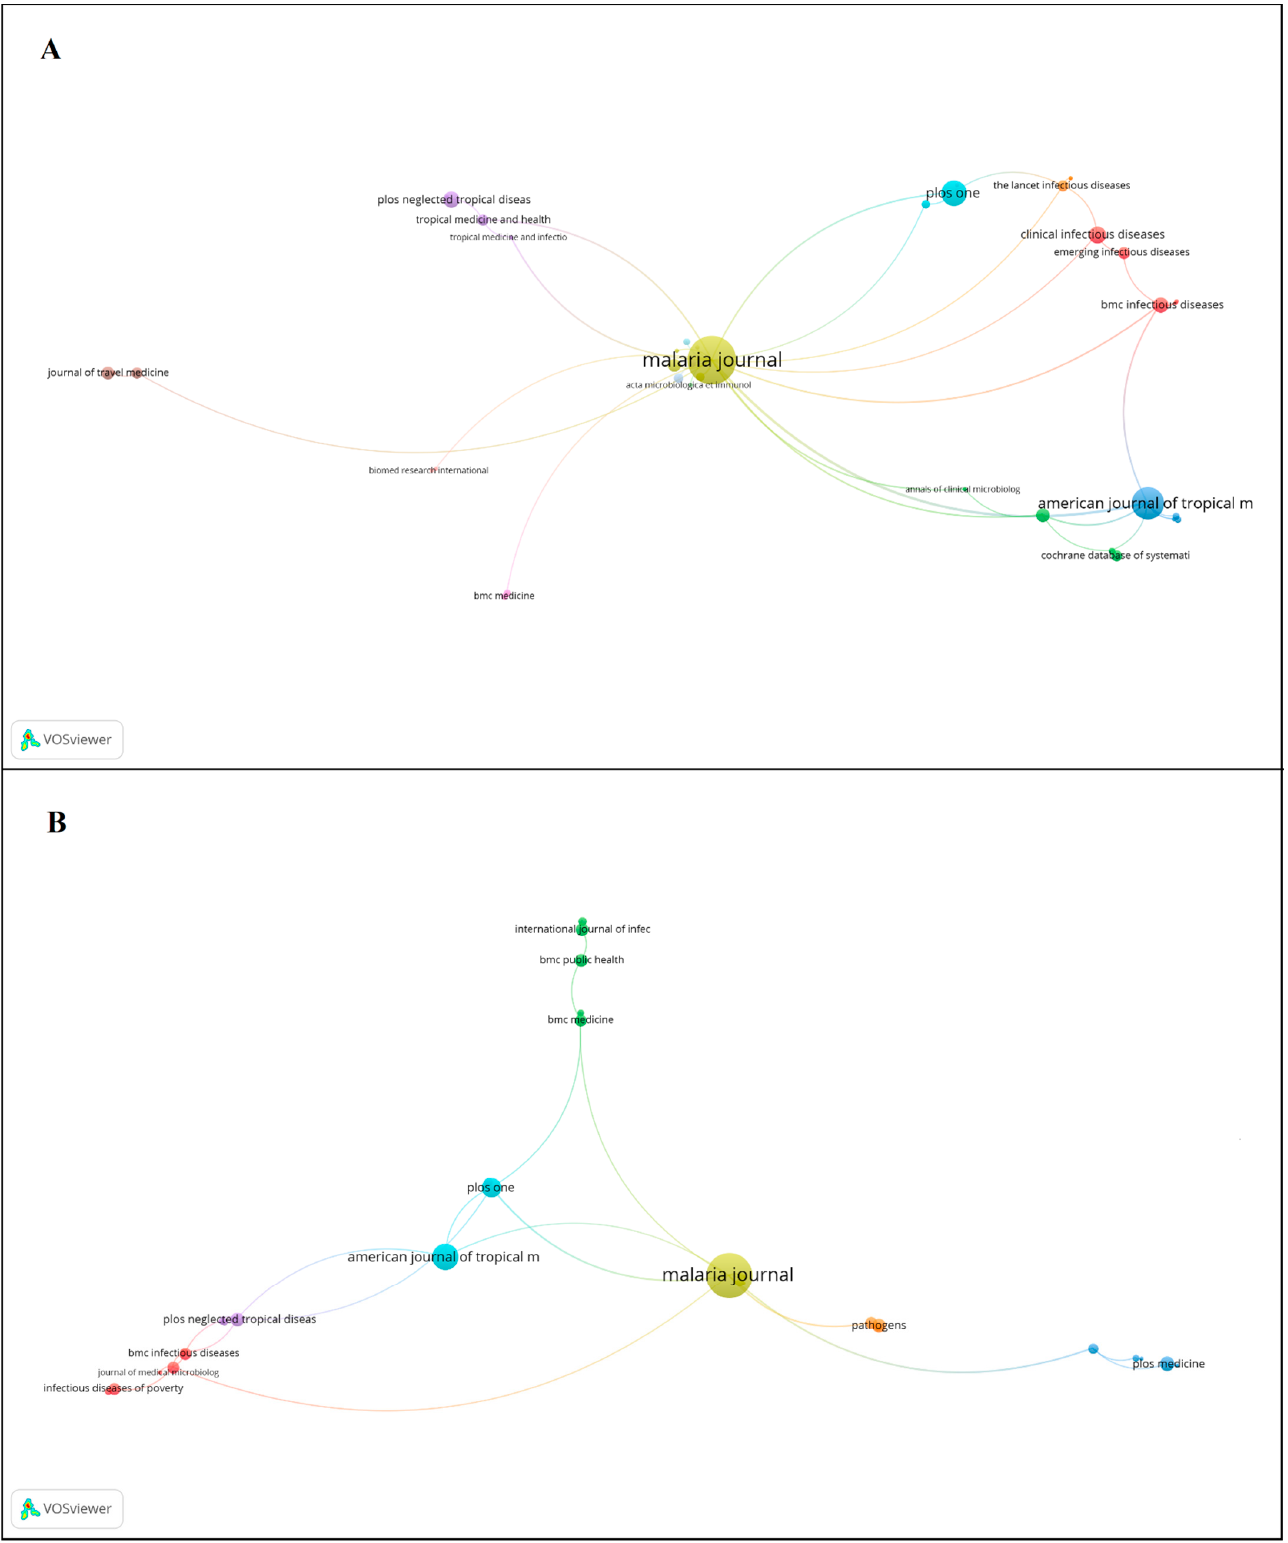
Figure 4. Journals that published malaria publications ( A ) before the COVID-19 pandemic, ( B ) during the COVID-19 pandemic.